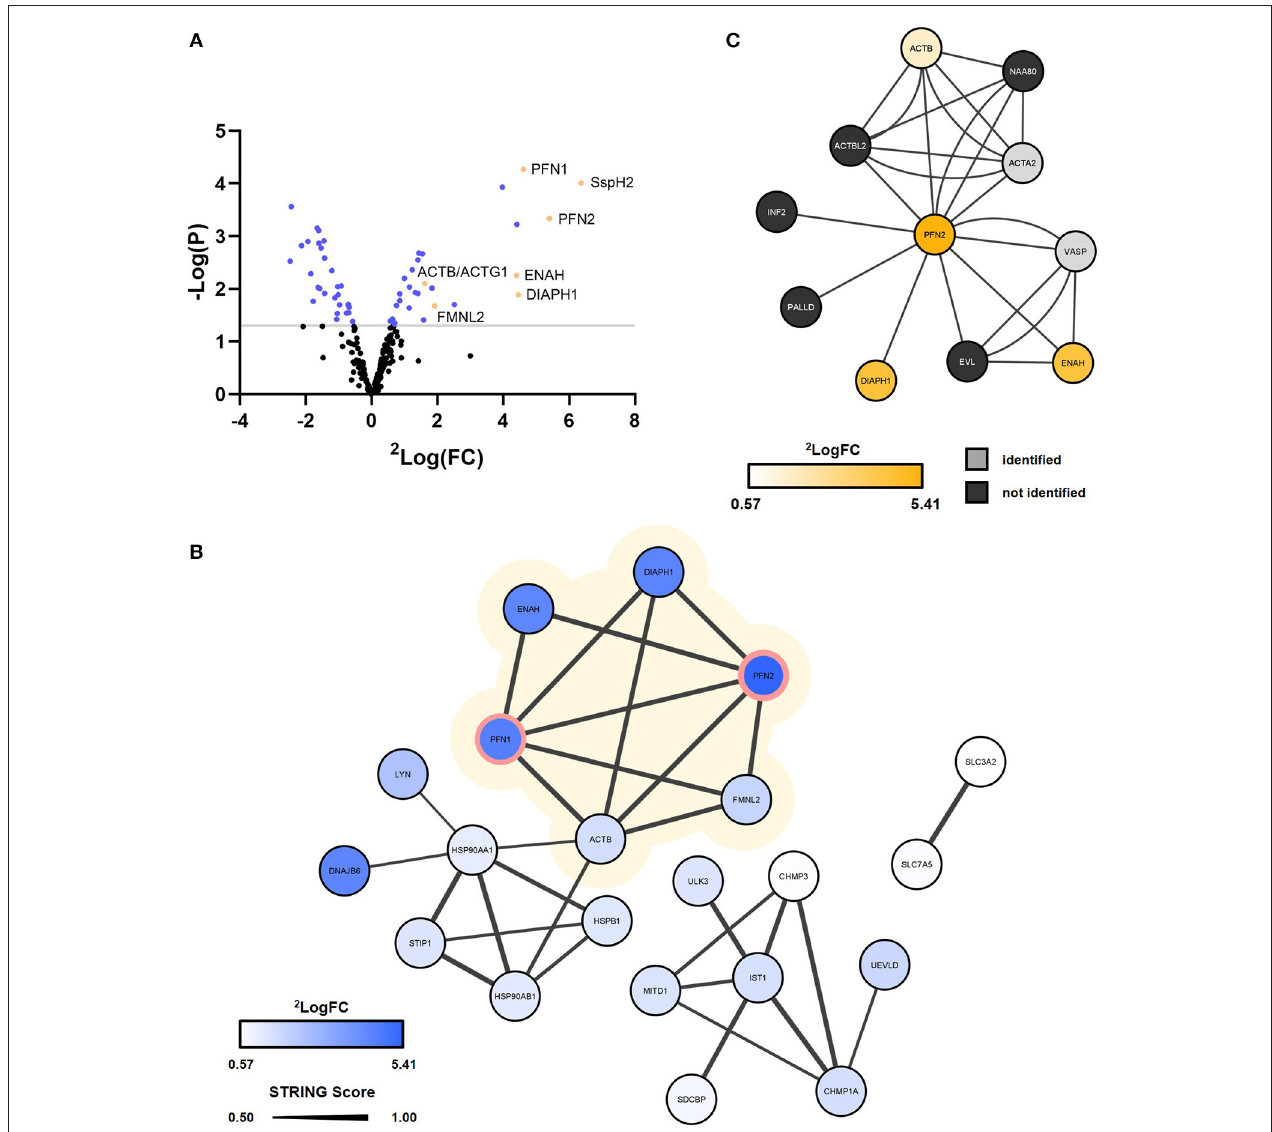
FIGURE 5 | Virotrap confirms interaction of S. Typhimurium effector SspH2 with PFN1/2 and potential interaction with other associated actin cytoskeleton components. S. Typhimurium (SL1344) effector SspH2 was subjected to MS-based Virotrap analysis. (A) Significant hits (Limma, p -value < 0.05) are shown in blue and yellow [i.e., for hits defined as “actin-binding” (keyword) or actin, i.e., ACTB]. Proteins uniquely identified in the Virotrap control samples were excluded from the statistical analysis and are not shown in the volcano plot. (B) Gag-SspH2 co-enriched proteins (Limma, p -value < 0.05) are visualized in a STRING interaction network with the known interactors of SspH2 (PFN1 and − 2) lined in pink ( Table 1 ). The protein SspH2 interaction network associated with actin (-binding) is shaded in yellow. Significantly enriched proteins disconnected from the networks were not included in the network representation. (C) The BioPlex 3.0 interaction network characterized using C-terminally FLAG-HA-tagged PFN2 by means of anti-HA affinity purification (AP)-MS in HEK293T. Corresponding log2 fold changes of GAG-SspH2 co-enriched proteins are color-coded in the network nodes. VASP did not meet the selection criteria for quantification and ACTA2 was not regulated in the Virotrap